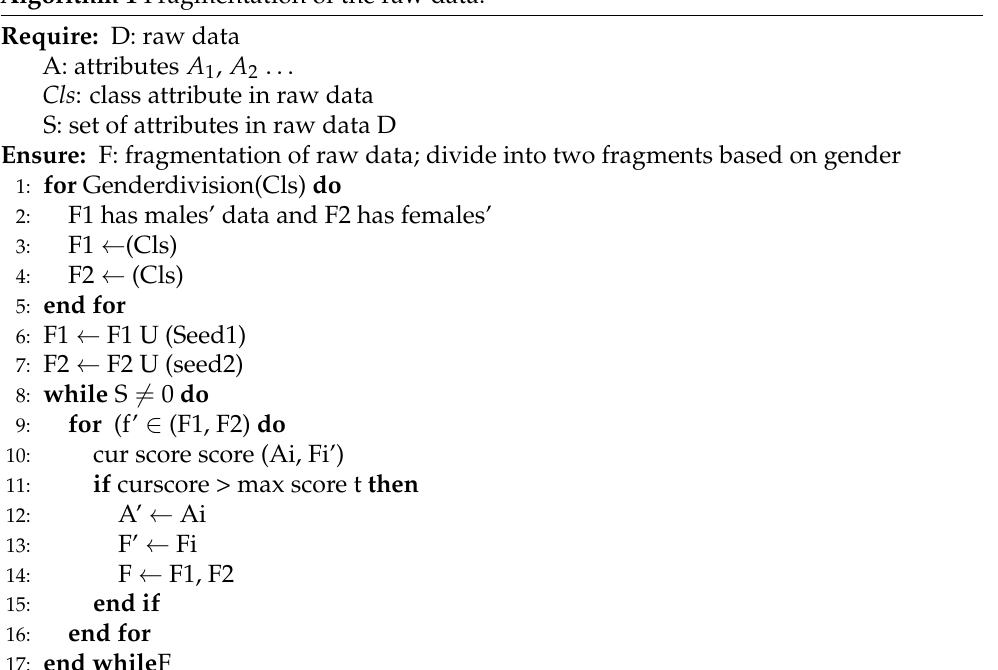
Algorithm 1 Fragmentation of the raw